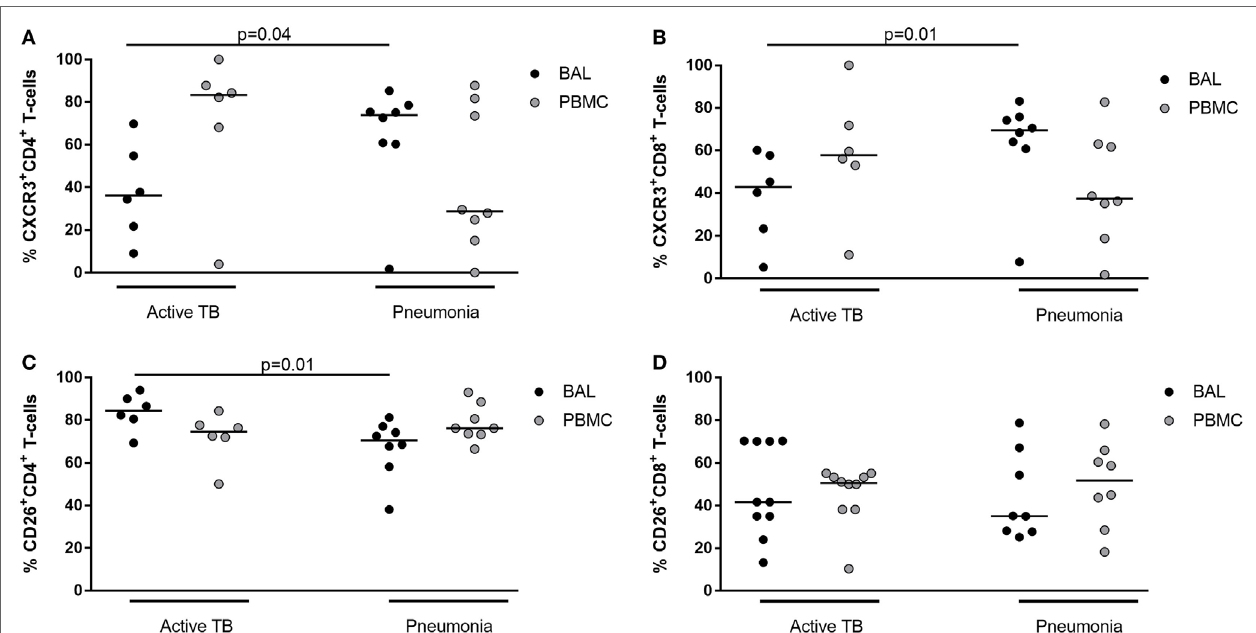
FigUre 9 | Frequency of CD4 and CD8 + CXCR3 + or CD26 + T-cells in bronchoalveolar lavage cells and peripheral blood mononuclear cells from patients with active tuberculosis (TB) and